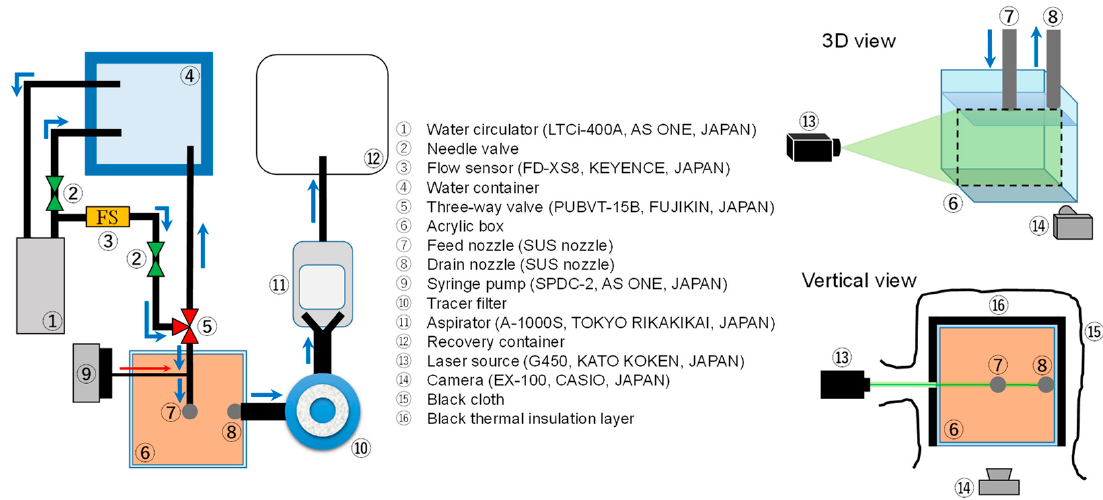
Figure 2. A schematic of the experimental setup for fl ow visualization.